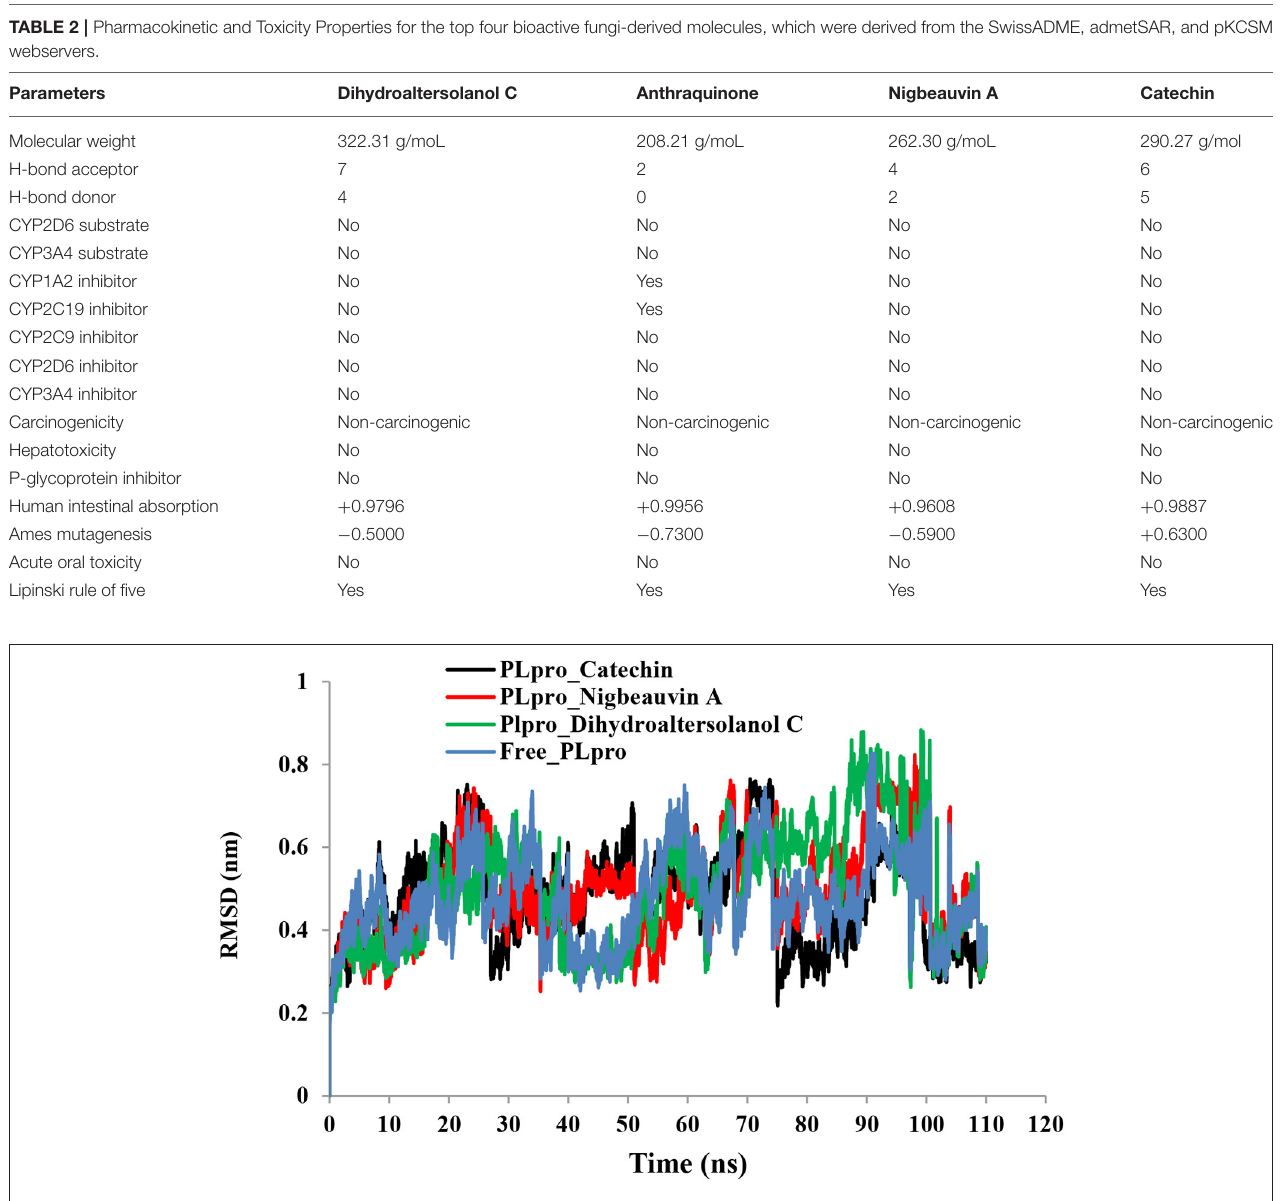
Frontiers in Medicine |